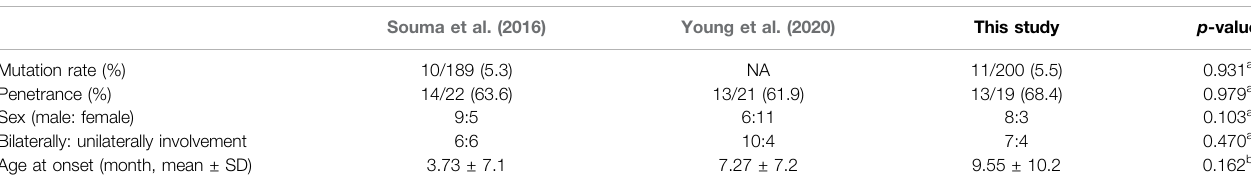
TABLE 2 | Comparison of clinical characteristics of TEK-mutated PCG